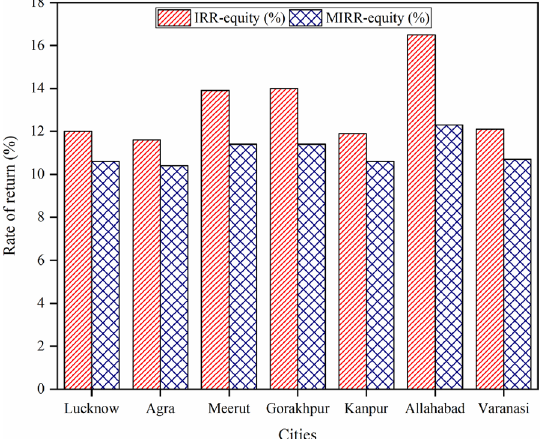
Figure 8. Internal and modified internal rate of return on equity of all cities.